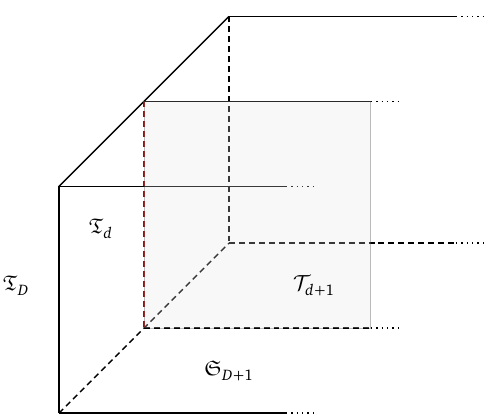
Figure 10: Relative defect T inside a relative theory T d attached to a TQFT S , while the relative defect T D + 1 defect S of the TQFT S d + 1 D + 1